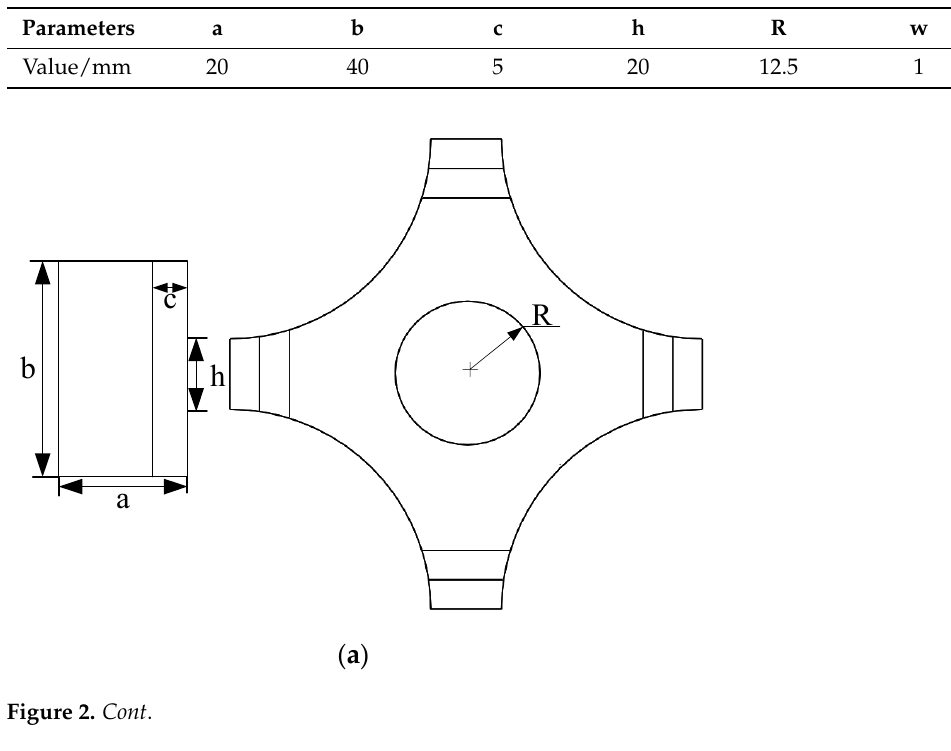
Table 2. Table 2. Model geometric parameters.